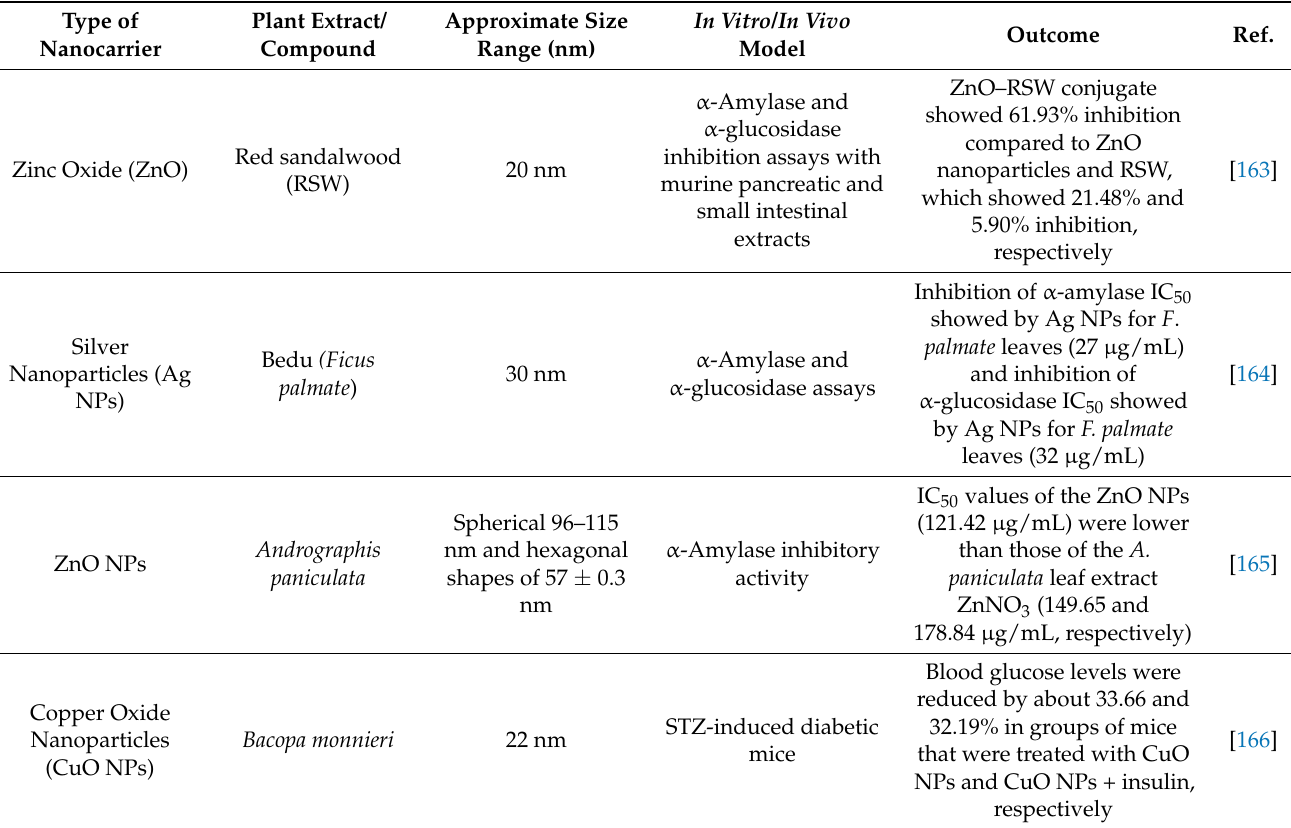
Table 3. Metallic nanoparticles for plant-based antidiabetic